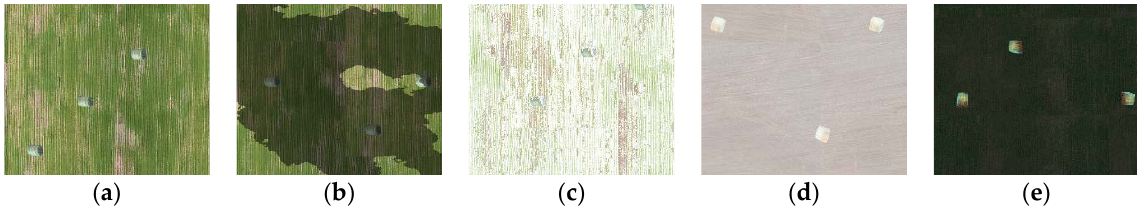
Figure 10. Examples of augmented bale images with multiple environmental conditions: ( a ) summer w/good illumination; ( b ) summer w/shadow; ( c ) winter w/snow; ( d ) early winter w/haze; ( e ) summer w/dark illumination.